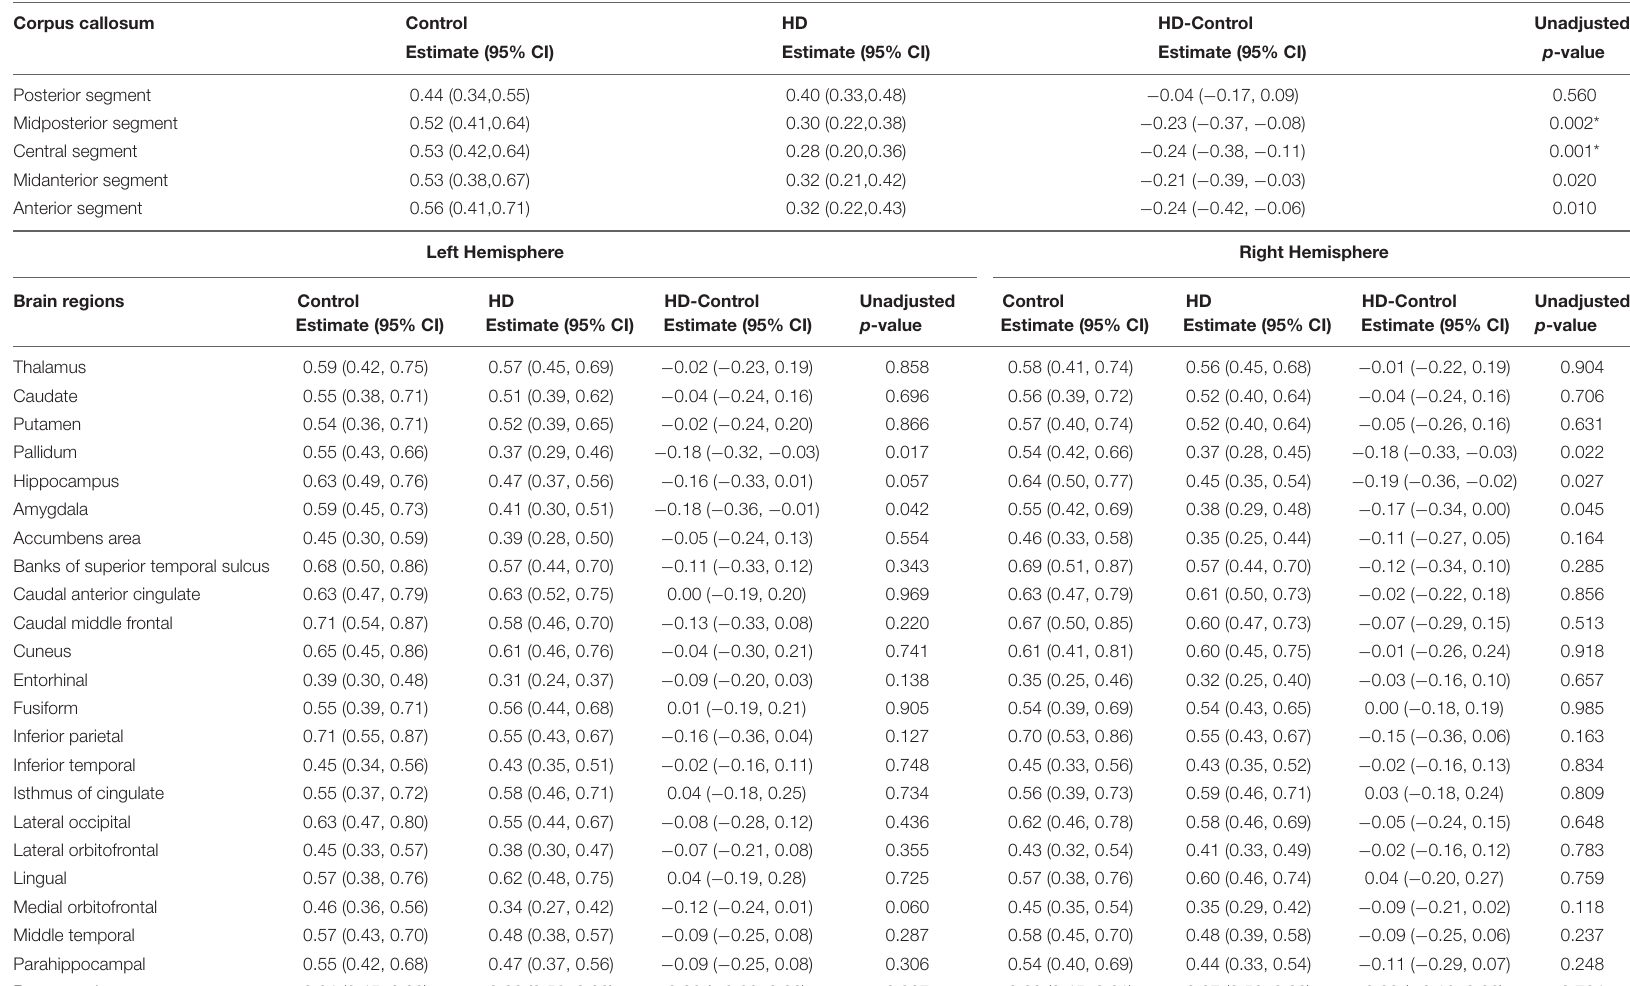
TABLE 2 | Association between Fisher-transformed cross-correlation values and disease designation (HD vs. Control) after adjusting for